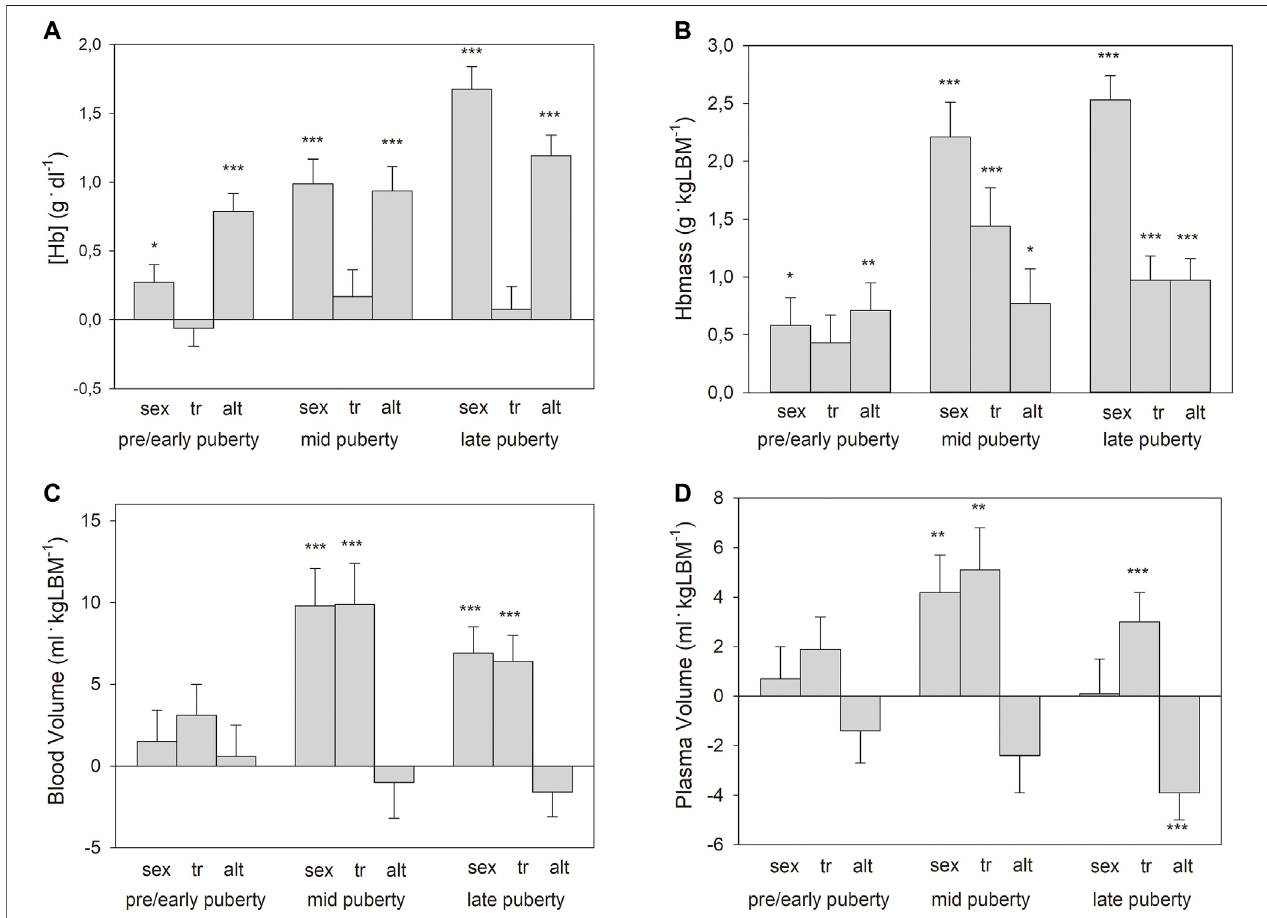
FIGURE 1 | Main effects with standard errors calculated by multiple regression analysis separately for the pooled puberty stages for sex (boys vs. girls), training status (tr, trained vs. untrained), and altitude (alt, 2,600 m vs. 1,000 m) on: (A) hemoglobin concentrations ([Hb]); (B) . Hbmass; (C) . blood volume; and (D) . plasma volume. Data for Hbmass, BV, and PV are normalized to lean body mass (LBM). Signi fi cance of effects: * = p < 0.05, ** = p < 0.01, *** = p < 0.001.